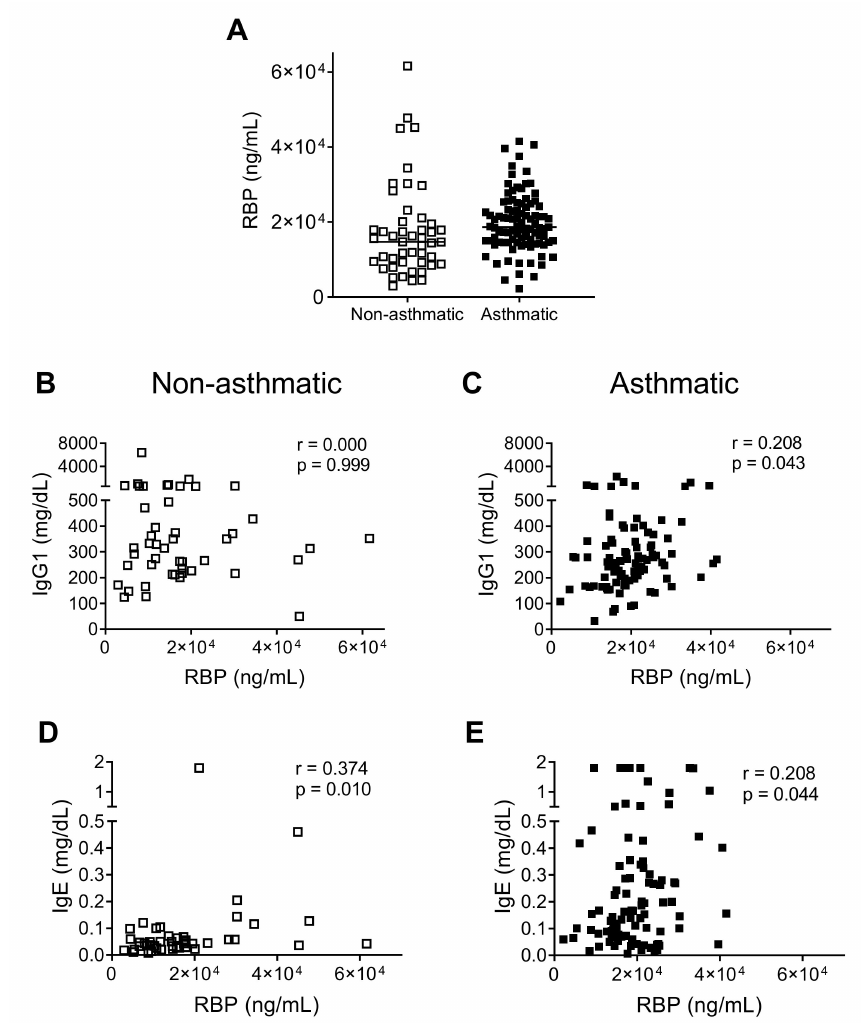
Figure 4. Correlation between retinol binding protein (RBP) and immunoglobulin (Ig). ( A ) RBP levels were compared between the two patient groups. Lines show the median in each group. ( B , C ) Asthmatics (but not controls) had moderate positive correlations between RBP and IgG1. Data were analyzed using the Spearman rank-order correlation test. ( D , E ) Spearman rank-order correlation analyses showed that both controls and asthmatics exhibited positive and moderate correlations between RBP and